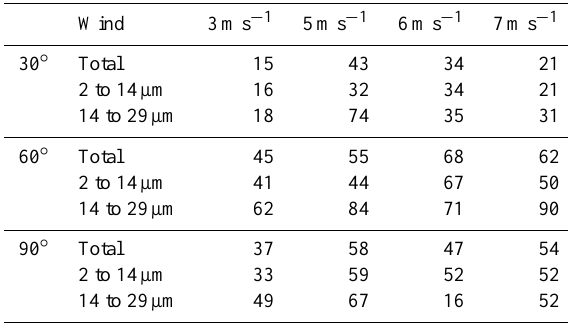
Table 5. Same as Table 4, for the